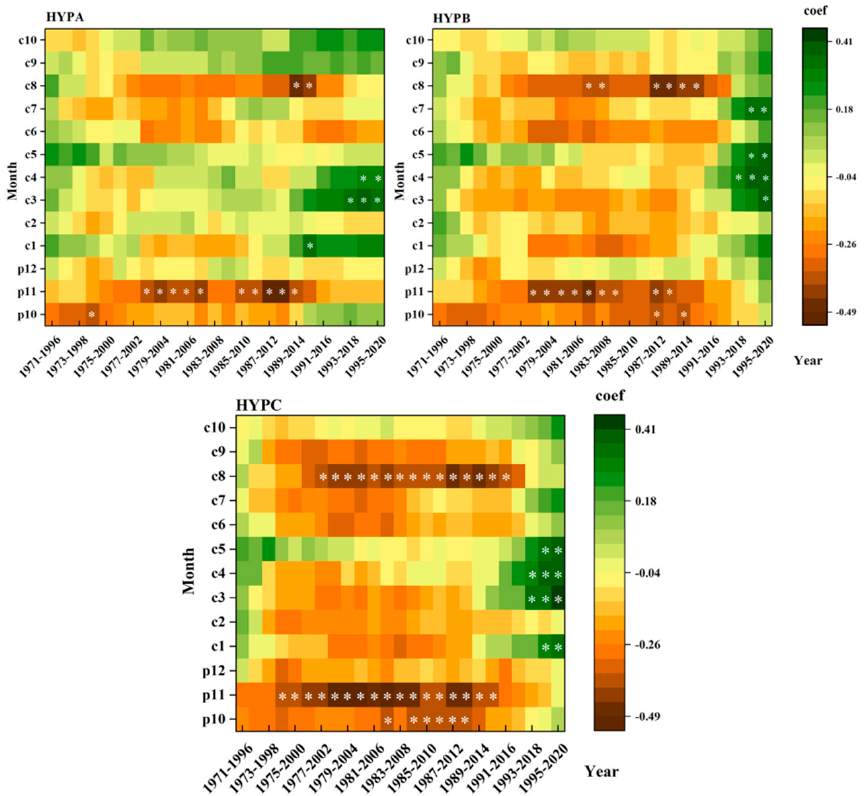
Figure 10. Sliding analysis results of the L . principis-rupprechtii tree-ring width index values derived at different elevations and the mean temperature from October of the previous year to October of the current year (with a sliding window of 26 years; p represents the previous year; c represents the current year; and the * symbol represents a significant correlation at the 0.05 level).